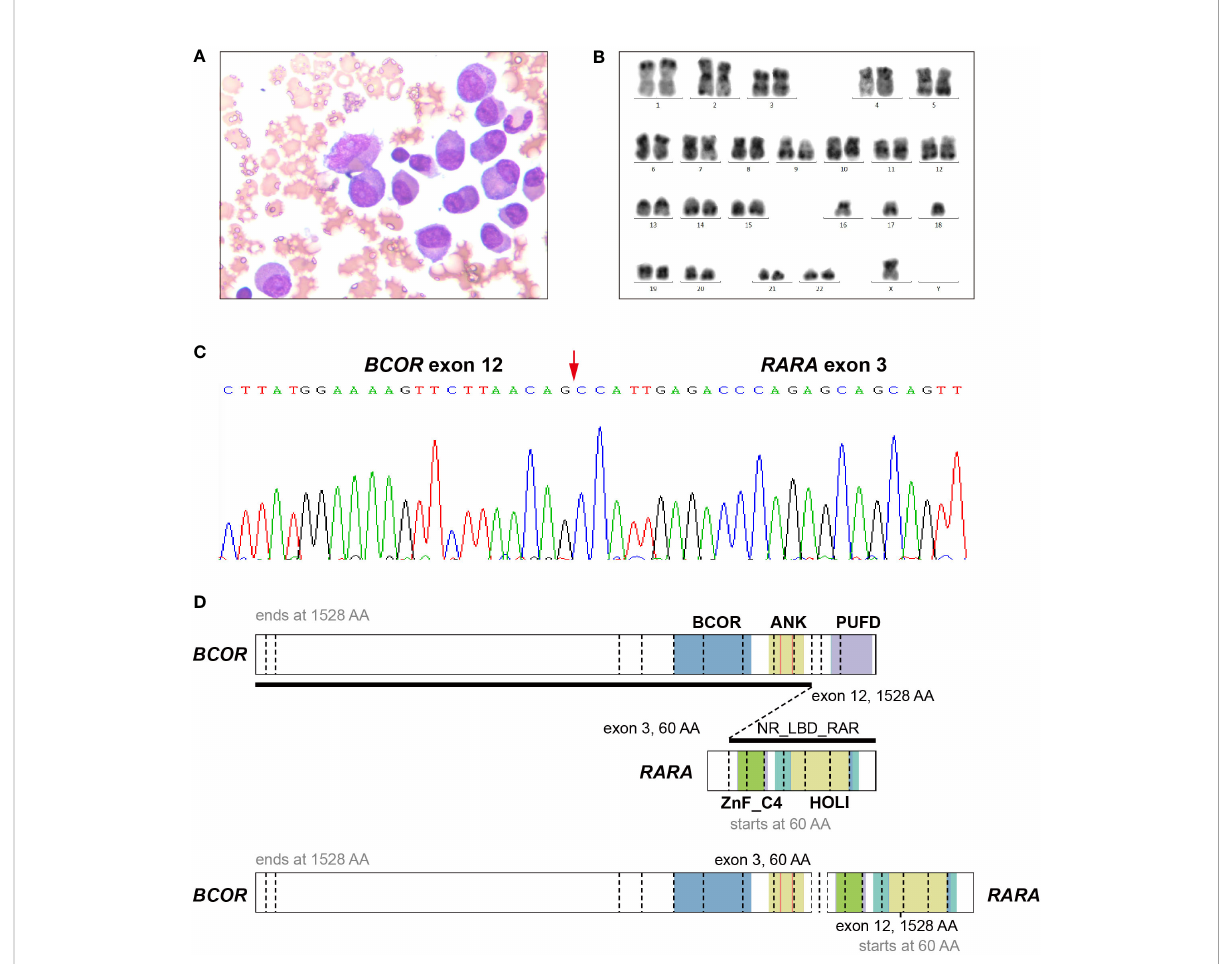
FIGURE 1 Morphology, cytogenetic and Molecular analysis of a bone marrow sample of the APL patient with BCOR-RARA. (A) May-Giemsa staining. Original magni fi cation × 400. (B) Karyotype analysis. 42, X, -Y, -15, -16, -18 was detected in the patient. (C) BCOR-RARA fusion sequence at the junction site. An in-frame BCOR-RARA transcript is shown with corresponding exon numbers. The junction is indicated by a red arrowhead. (D) Schematic representation of BCOR, RARA, and the BCOR-RARA fusion protein. BCOR-RARA protein retains both BCOR and ANK of BCOR and ZnF_C4 and NR_LBD of RARA. ANK, ankyrin repeats; PUFD, PCGF Ub-like fold discriminator of BCOR; NR_LBD_RAR, the ligand binding domain (LBD) of retinoic acid receptor (RAR); ZnF_C4, c4 zinc fi nger in nuclear hormone receptors; HOLI, Ligand binding domain of hormone